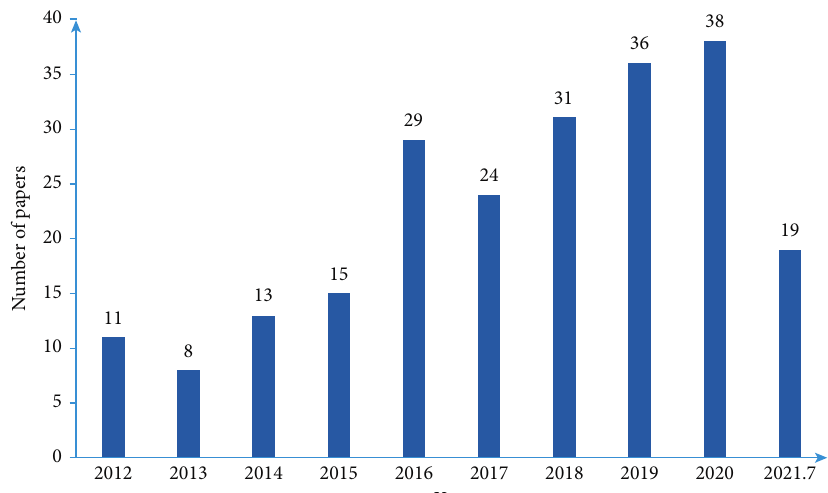
Figure 1: The increasing number of publications in marine object detection from 2012 to 2021 July (data from Google scholar advanced